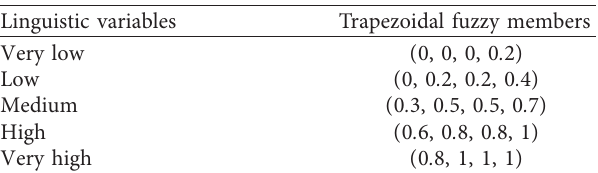
Table 3: Linguistic variables and corresponding trapezoidal fuzzy